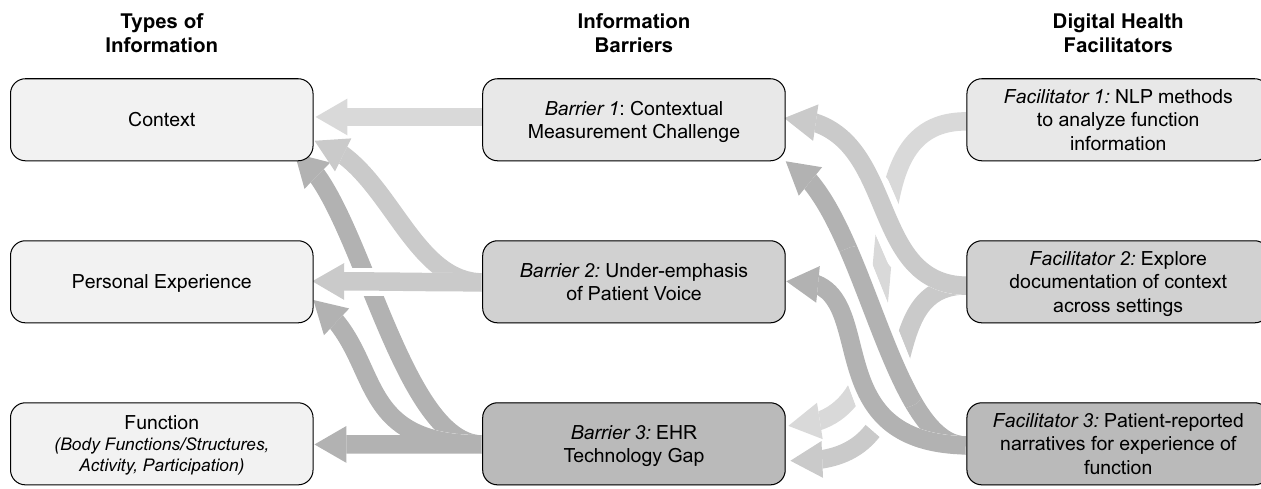
Fig 6. Relationships between multidimensional information on a patient’s situation information barriers limiting collection of this information and ways in which digital health technologies such as NLP can serve as facilitators to lower these barriers. NLP, natural language